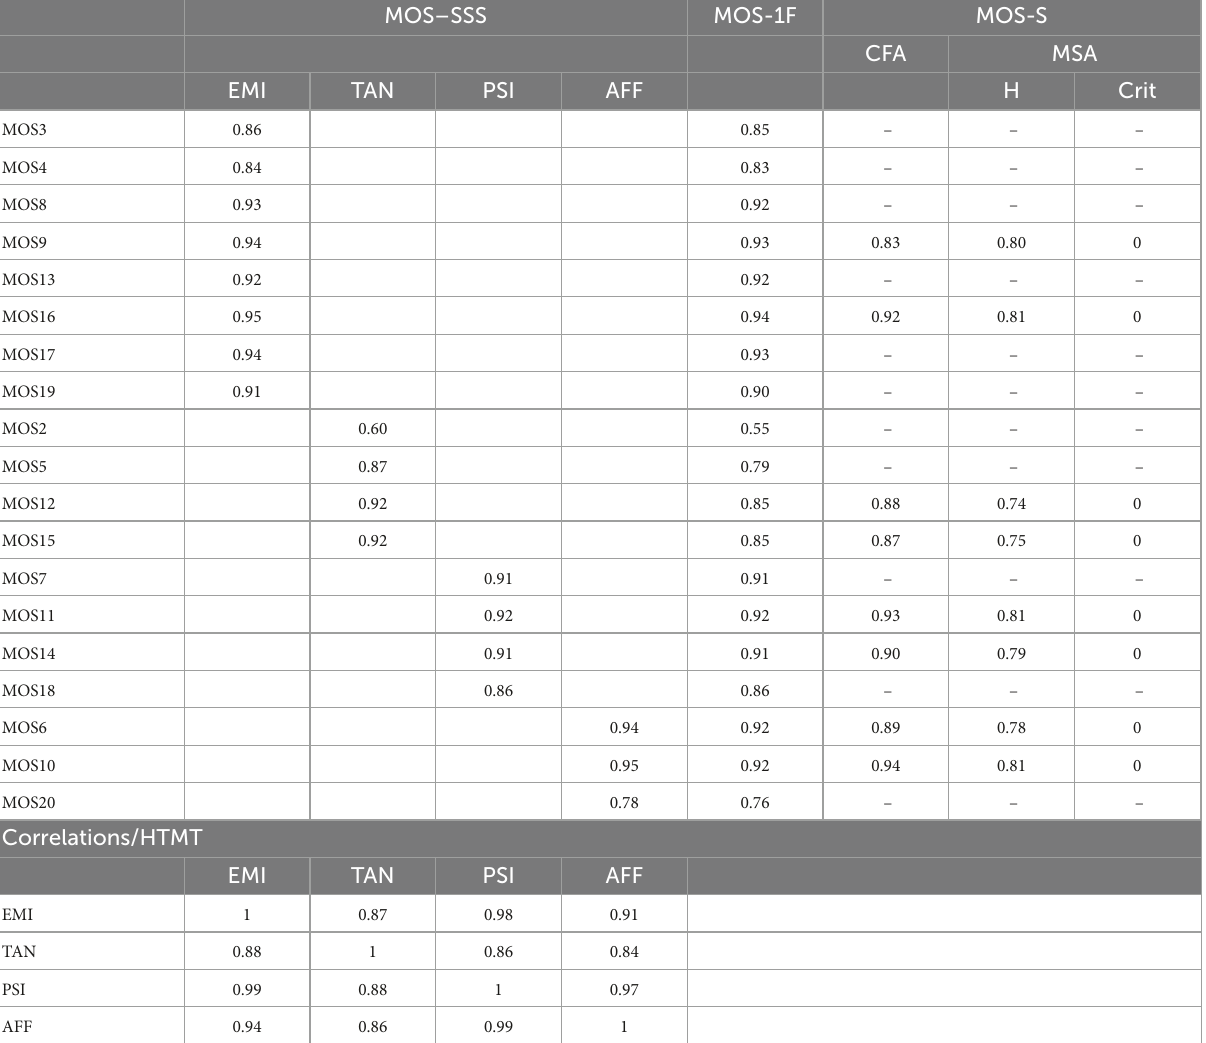
TABLE 6 CFA-SEM of the MOS-SSS and MOS-S ( n =